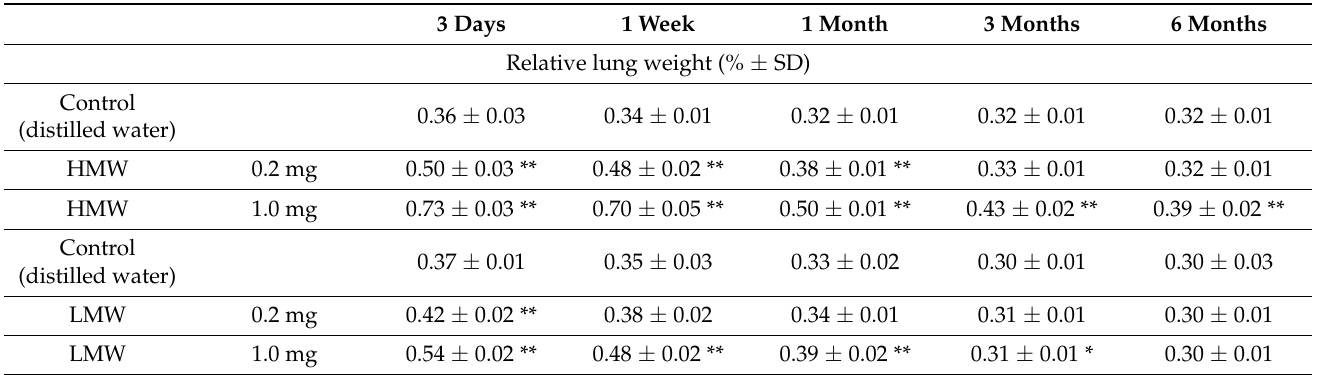
sustained throughout the observation period compared to the control group (Table 2). The HMW PAA-exposure lungs, especially the 1.0 mg-HMW PAA-exposure lungs, were more edematous and mottled than the LMW PAA-exposure lungs at 3 days after the instillation (Figure 2A(a–c),B(a–c)). Table 2. Relative lung weight.